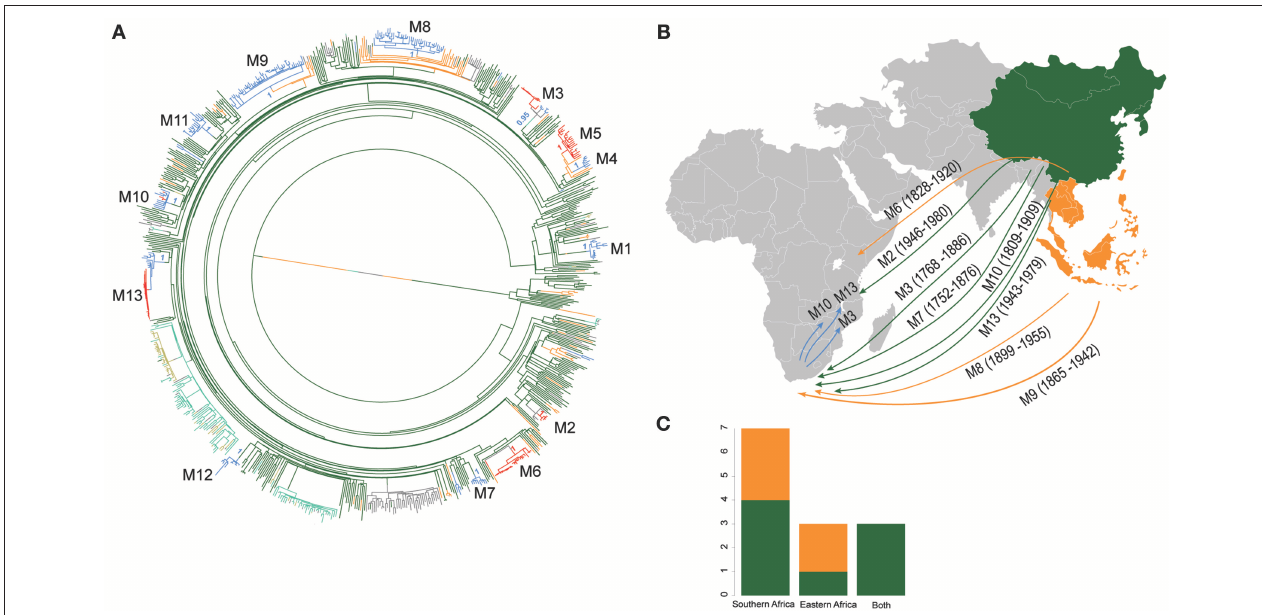
FIGURE 4 | Introductions of L2 strains to Africa. (A) Stochastic mapping of the geographic origin of L2 strain obtained with SIMMAP onto the Maximum Likelihood phylogeny of the 781 MTB Lineage 2 strains. Branches are colored according to the geographical region inferred and one random tree is represented. The 13 migration events to Africa (M1–M13) are indicated and summary posterior probabilities (from 100 runs) of the ancestral states (colored according to their geographical region) are indicated at the nodes defining each M event (B) Proposed scenario for representative events of the multiple introductions of L2–Beijing into Africa. (C) Plot summarizing the number of introduction events to Eastern and Southern Africa from East- and Southeast Asia. Color codes are the same as in Figure 3 .